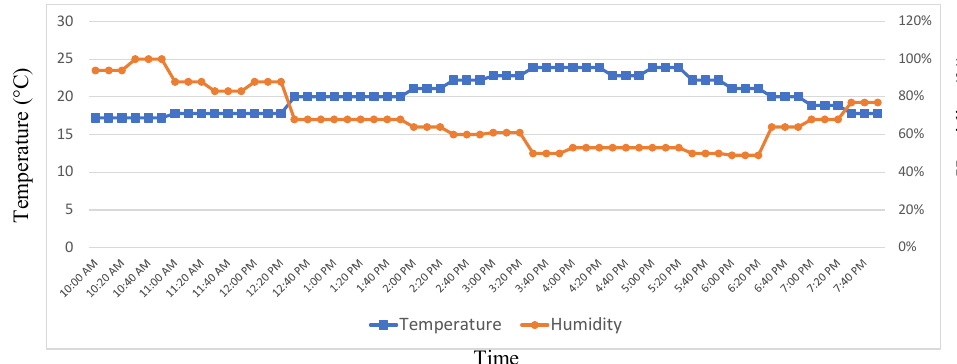
Figure 13. Temperature and humidity records of the agro-weather station.